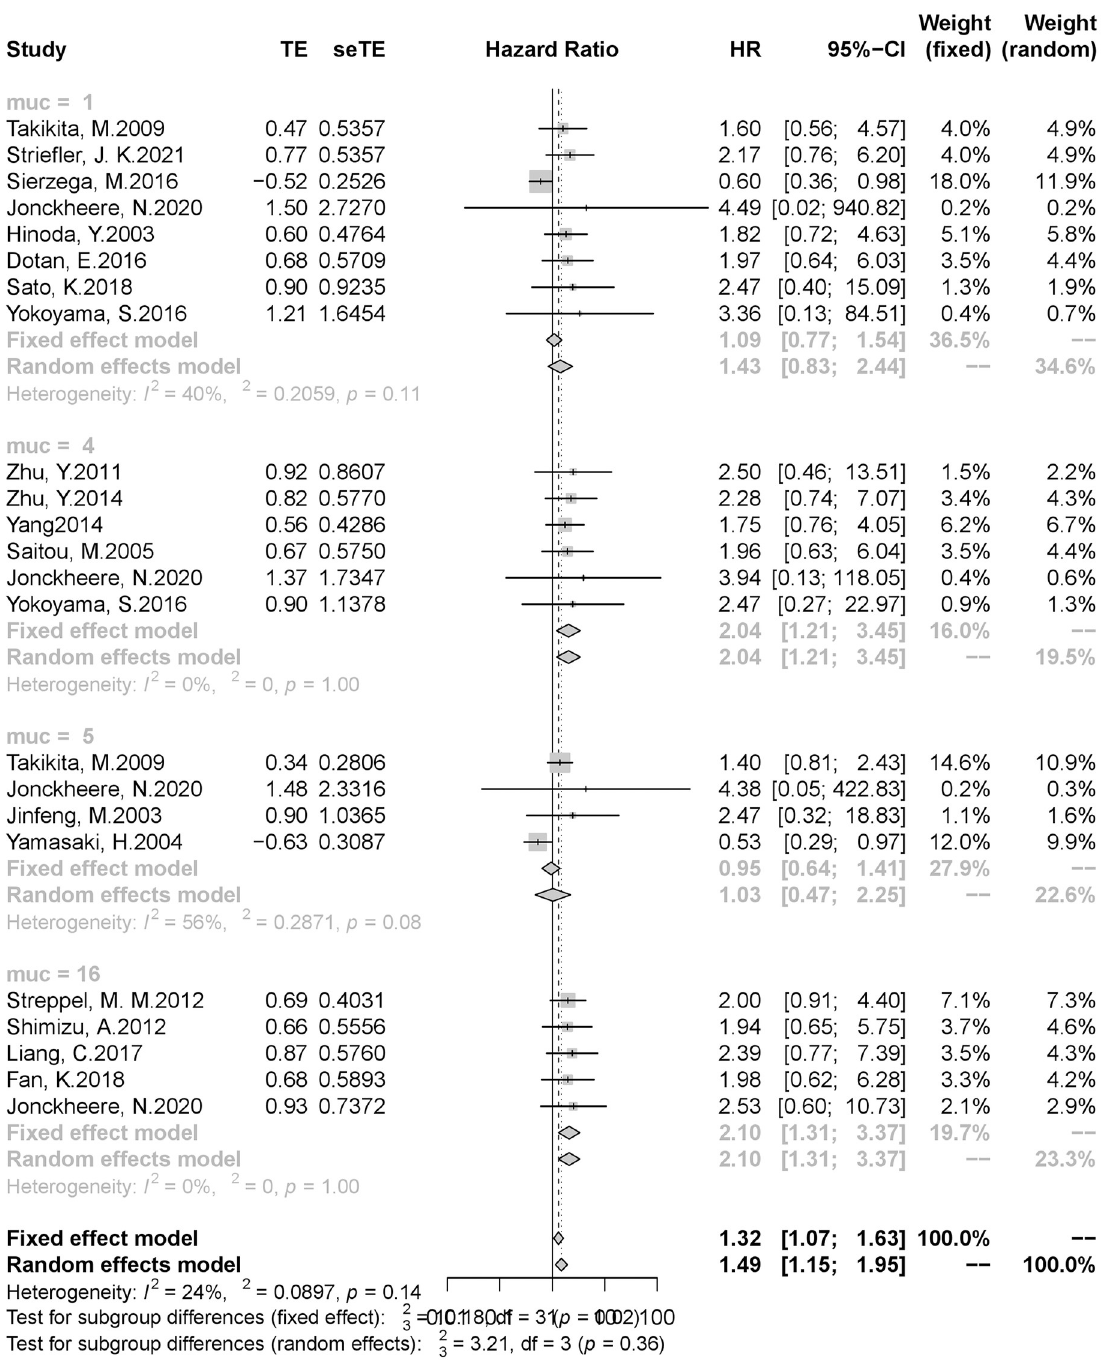
PLOS ONE | https://doi.org/10.1371/journal.pone.0269612 June 16, 2022 8 /